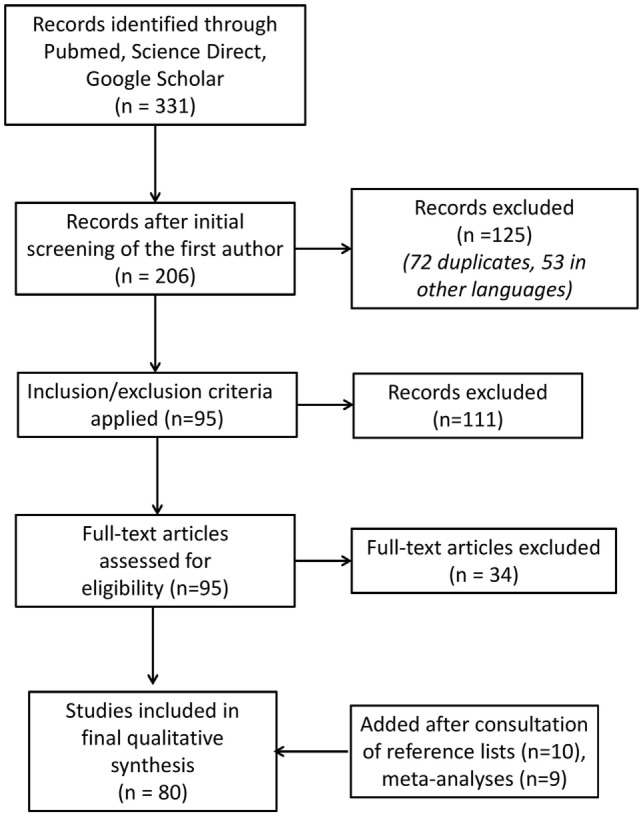
Study flow diagram.